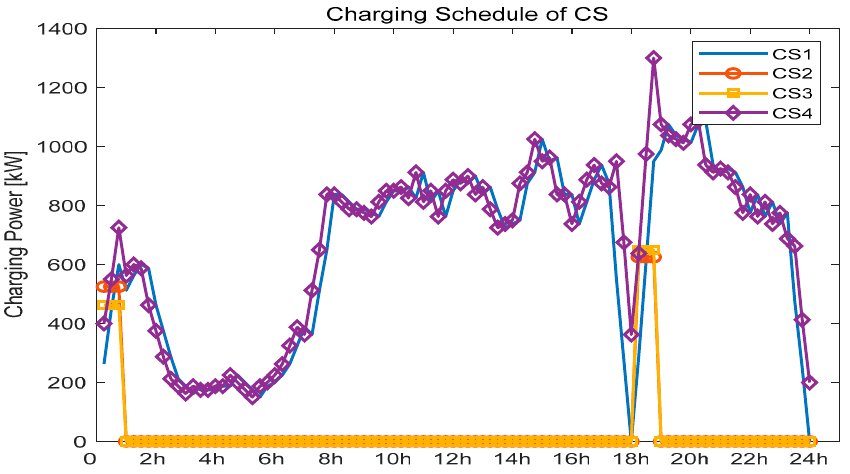
Figure 15. Charging schedules of CSs in Case 3.